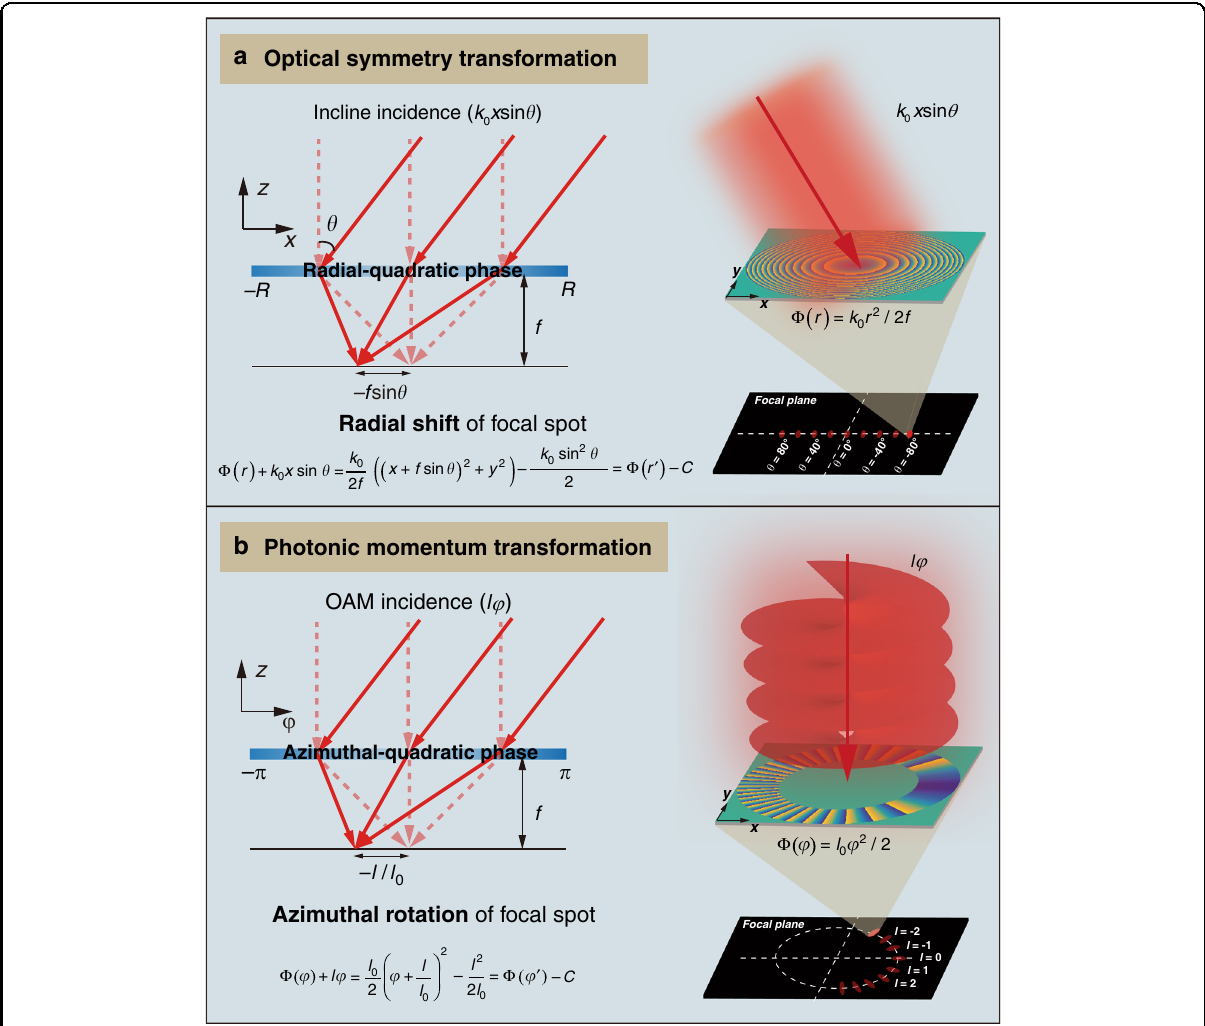
Fig. 1 Analogy of two types of optical transformations based on a single quadratic phase mask. a Principle of the optical symmetry transformation that translates the rotational symmetry of wide FOV illumination into a transverse symmetry of focus shift, which is utilized for single thin metalens-based wide FOV imaging and wide-angle beam scanning. b Principle of the PMT that translates different OAM modes into rotating focusing patterns, which is leveraged for single-metasurface-based single-shot OAM